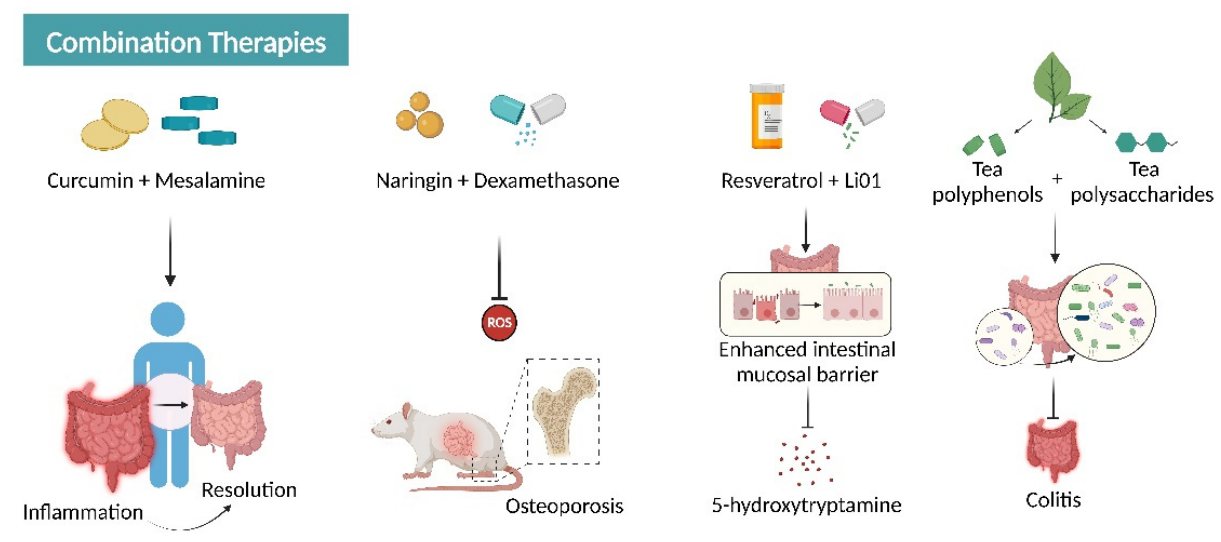
Figure 7. Drug combinations enhance the therapeutic effect of polyphenols in IBD. Combination strategies can exert synergistic effects and reduce side effects to facilitate the application of polyphenols in IBD.